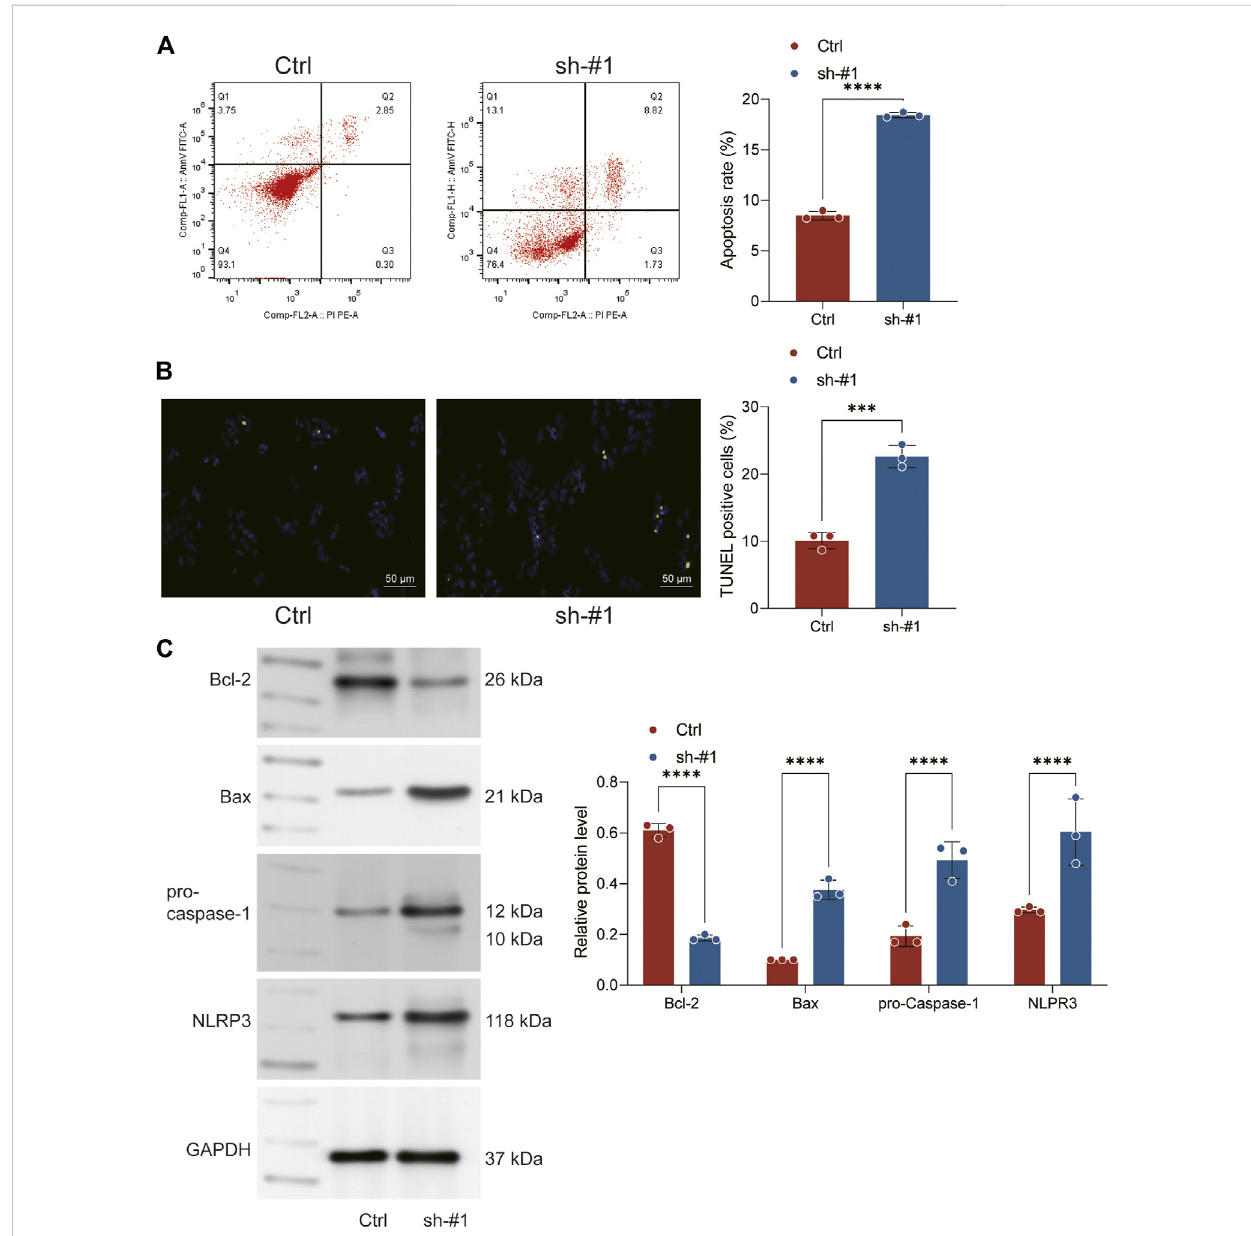
FIGURE 7 Knockown of FADD promotes the apoptosis and pyroptosis. Notes: (A) Flow cytometry was performed to detect cell apoptosis between sh-FADD and control cells; (B) TUNEL staining was performed between sh-FADD and control cells; (C) Western blot was performed to detect the protein level of speci fi c markers involved in apoptosis and